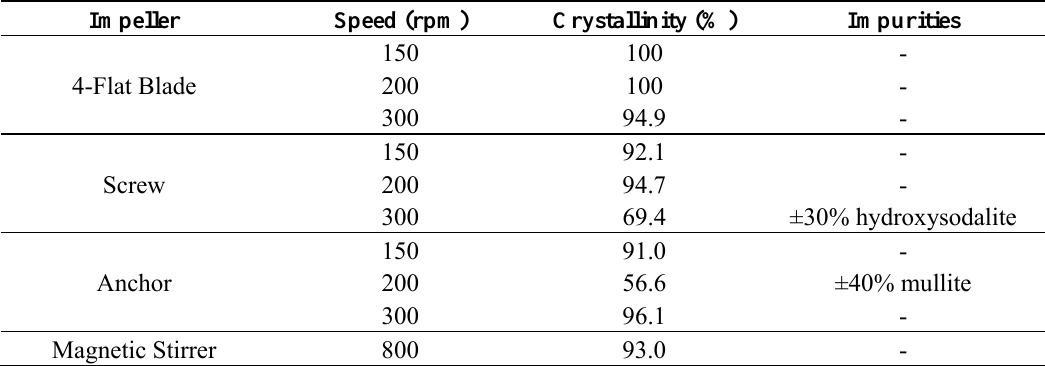
Table 2. Percentage crystallinity of zeolite